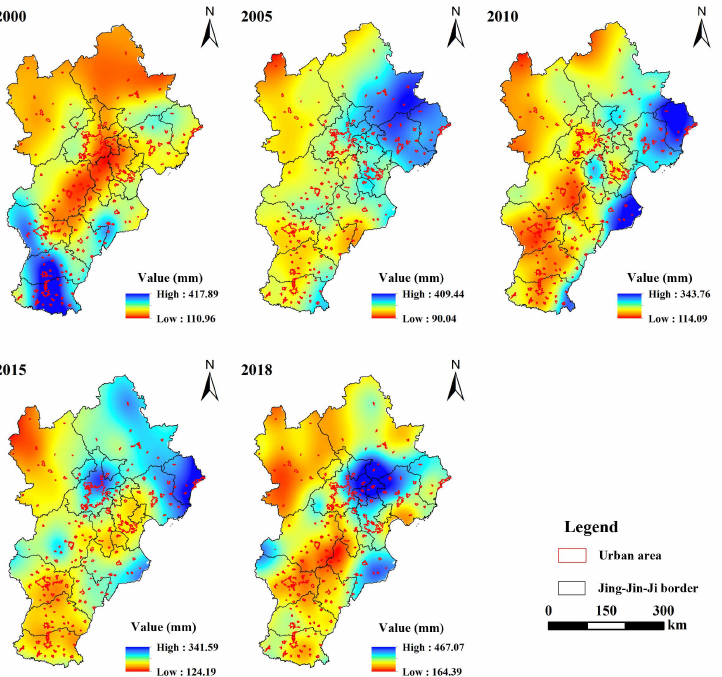
Figure 2. Spatial distribution of summer precipitation in different periods in the Beijing–Tianjin– Hebei region.